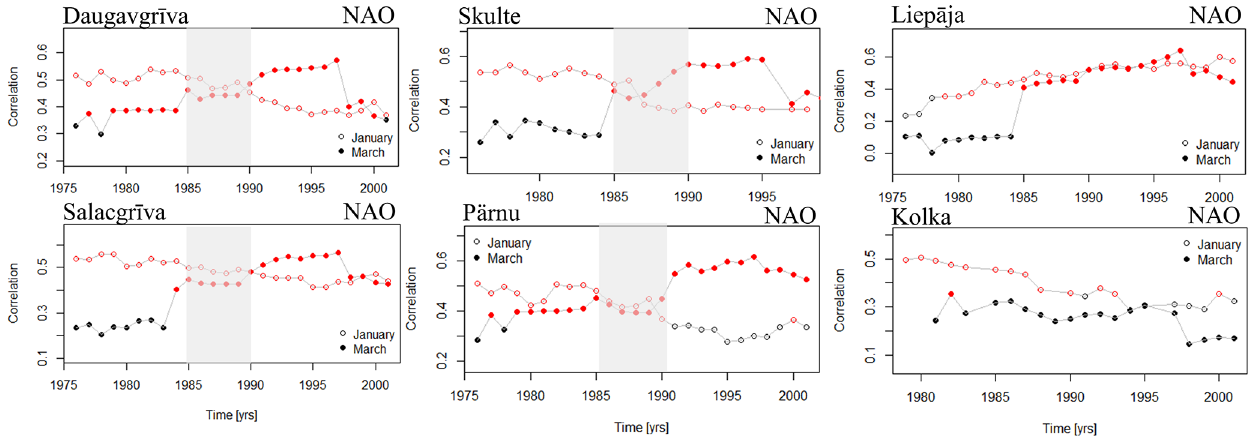
Figure 10. Sliding-correlation results between the water level maxima in January (open circles) and March (solid circles) with the NAO index. The correlation is calculated using a window of 30 years. The correlation coefficients with a significance of more than 95% are marked in red. The gray rectangle highlights the period of the abrupt regime shift.